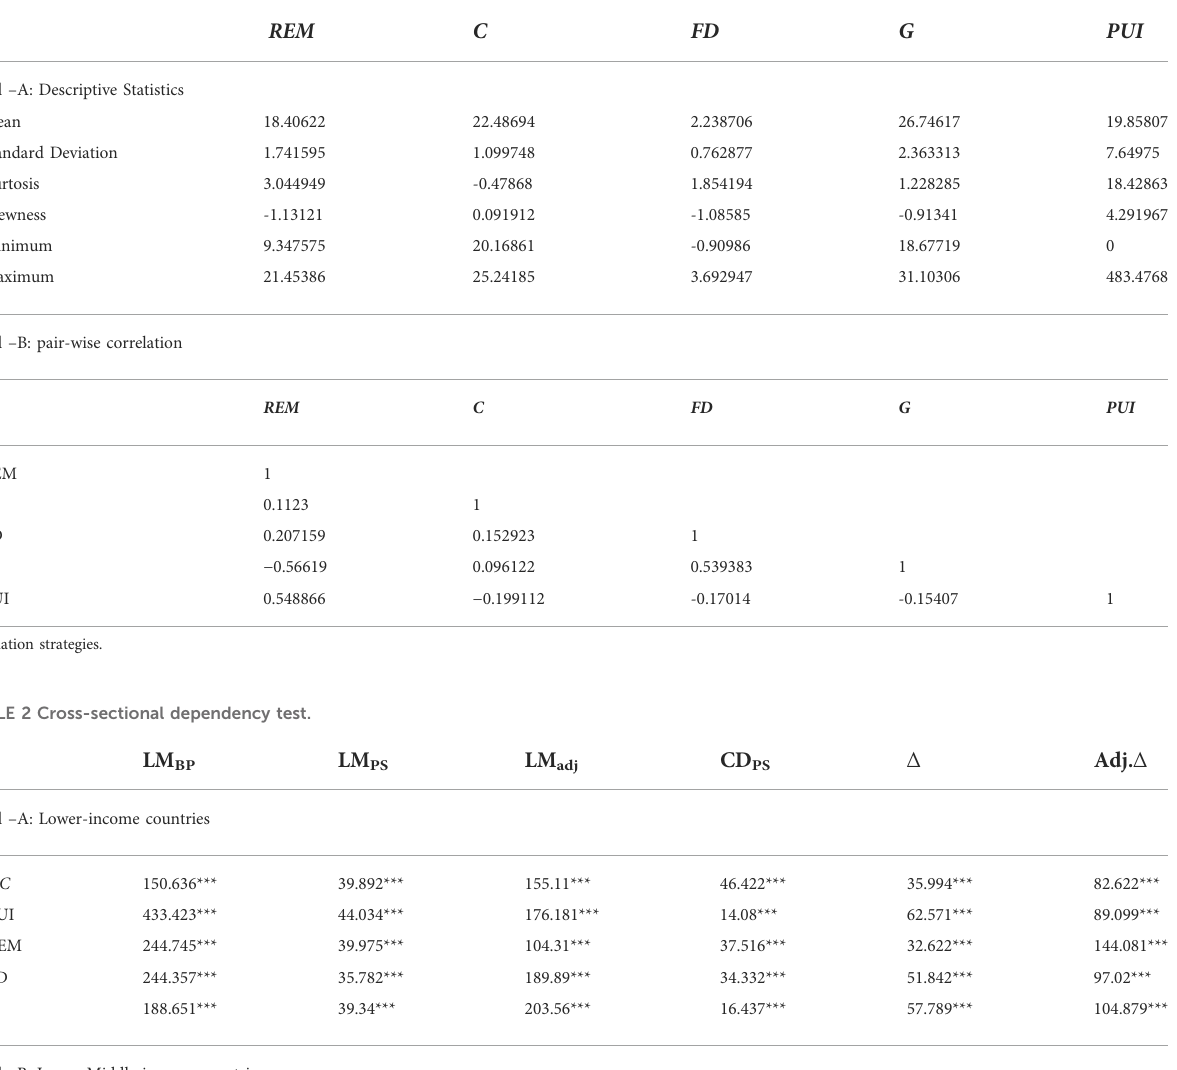
TABLE 1 Results of descriptive and pairwise correlation (full sample).